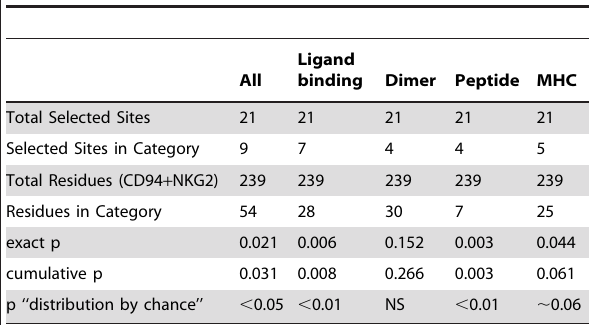
Table 2. Natural selection targeted the CD94/NKG2 residues interacting with the peptide presented by MHC class I ligands in ‘‘lower’’ primates.